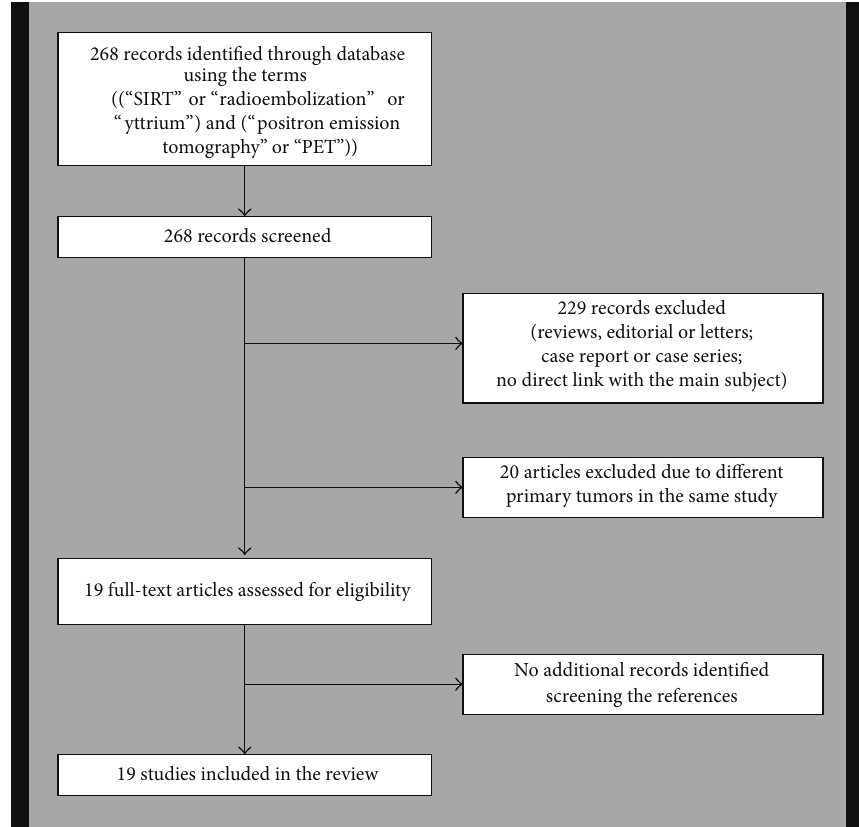
Figure 1: Flow chart of the search for eligible studies on the role of 18 F-FDG-PET or PET/CT in patients with CRLM undergoing